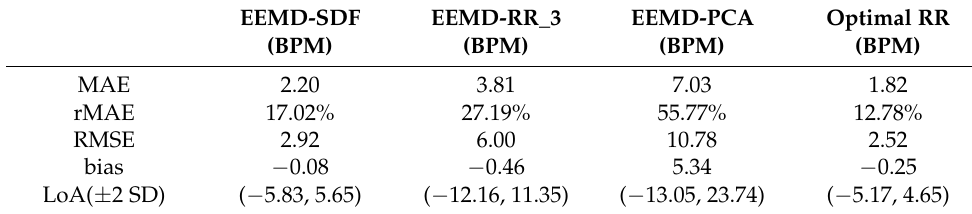
Table 5. The estimated RR using different methods.